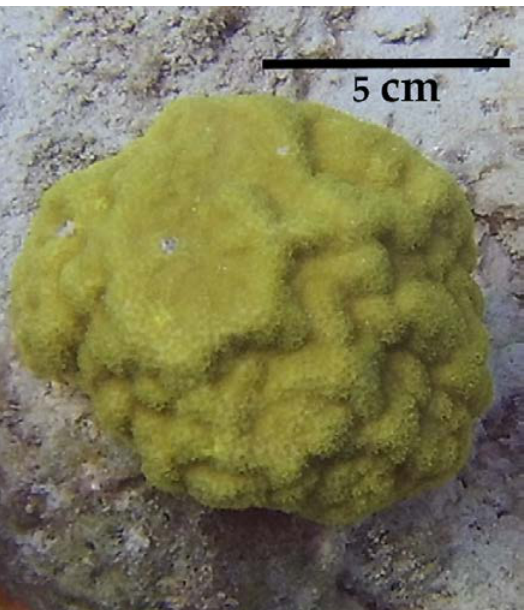
Figure 3. A colony of Porites astreoides , found at a depth of 2 m on the island of Bonaire, Dutch Caribbean .